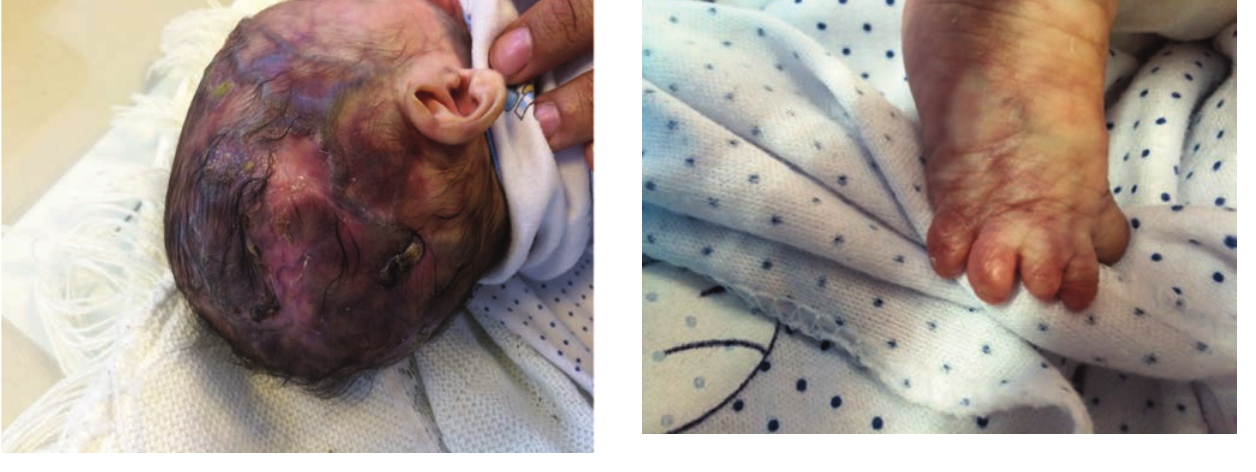
Figure 1. Multiple vertex skin defect and dilated veins. Figure 2. Hypoplastic fingers and nails.